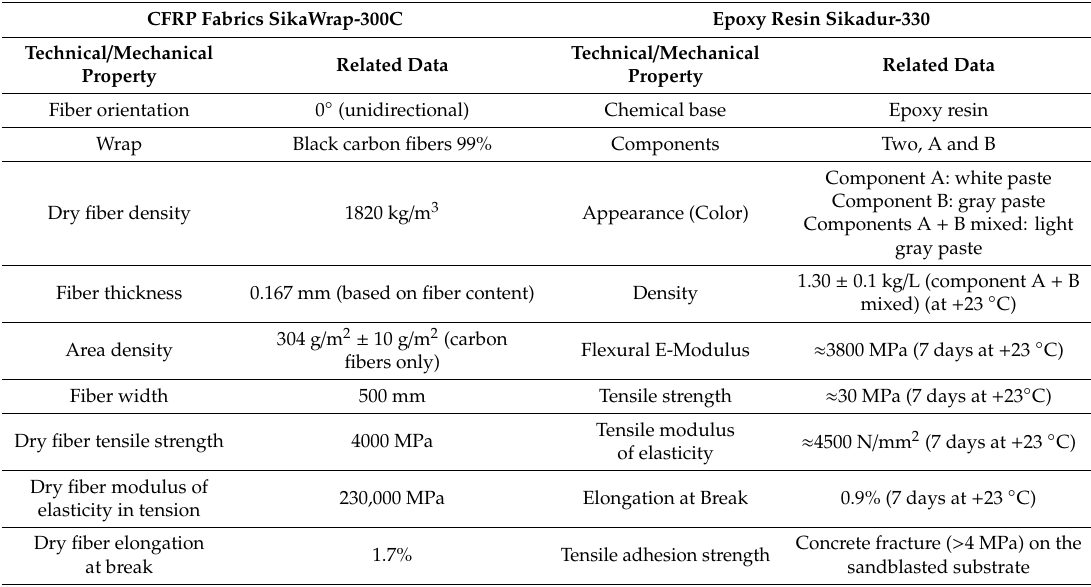
Table 3. Technical and mechanical properties of carbon fiber-reinforced polymer (CFRP) composite.